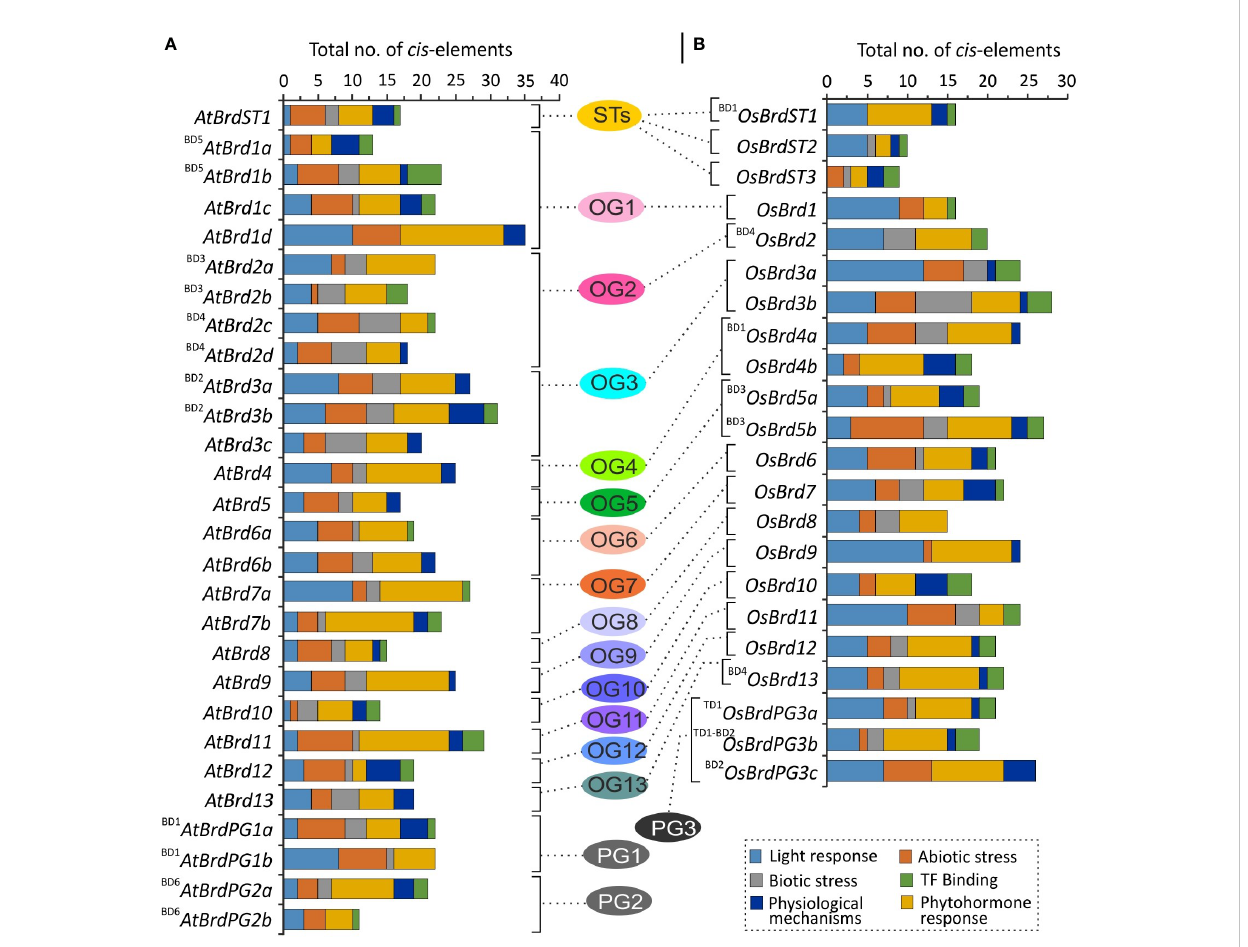
FIGURE 5 Diversity of cis -regulatory elements in the upstream region (-2000 bp) of A. thaliana (A) and O. sativa (B) Brd -genes, belonging to thirteen ortholog groups (OG1-13), three paralog groups (PG1-3), and singleton category (STs), as per analysis at PlantCARE database. The Brd-members speci fi c to each group are arranged side-by-side for comparison, and the designations ‘ BD ’ and ‘ TD ’ in the names indicate the block or tandem duplication. Different functional categories of cis -motifs are shown by different color